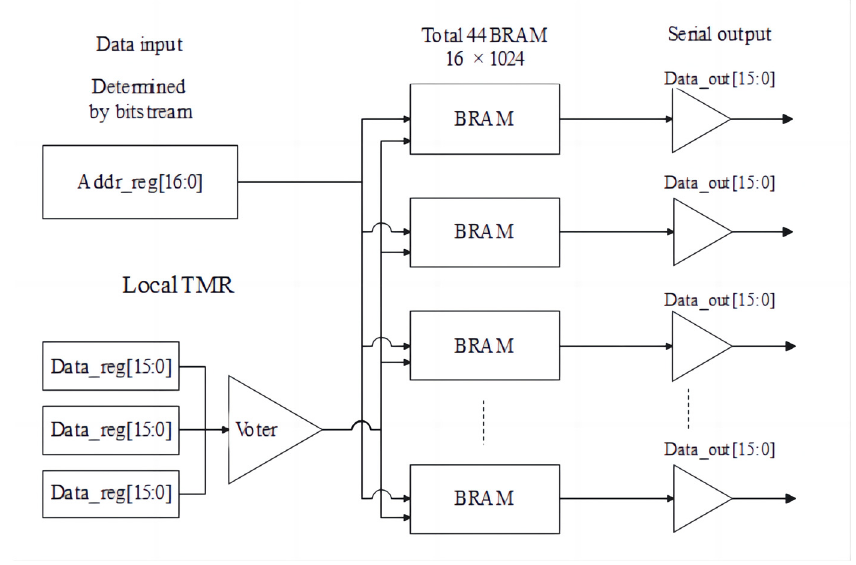
Figure 3. SEE test circuit design for block RAM.